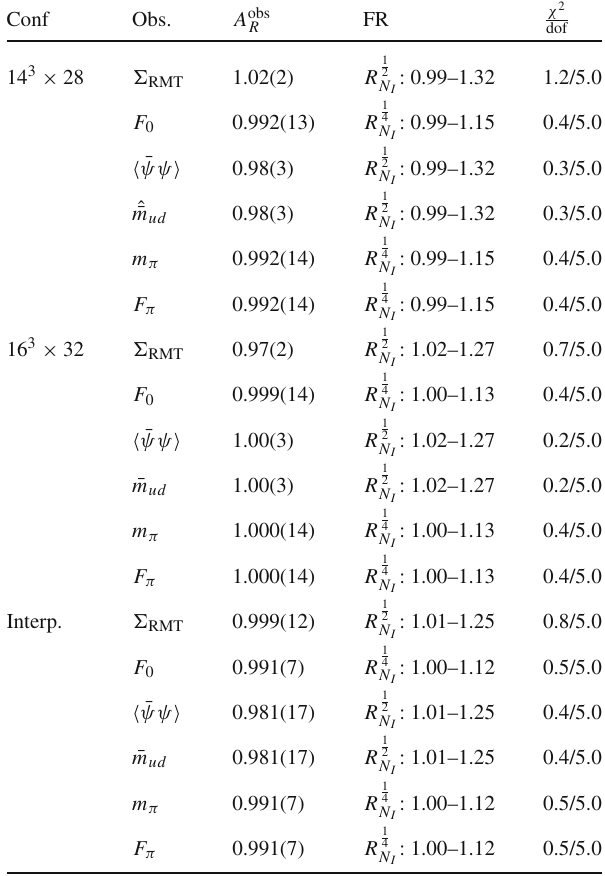
obtained by the lin- R 1 1 2 4 R R and R obs = A obs . The ratios are N I N I R R = R